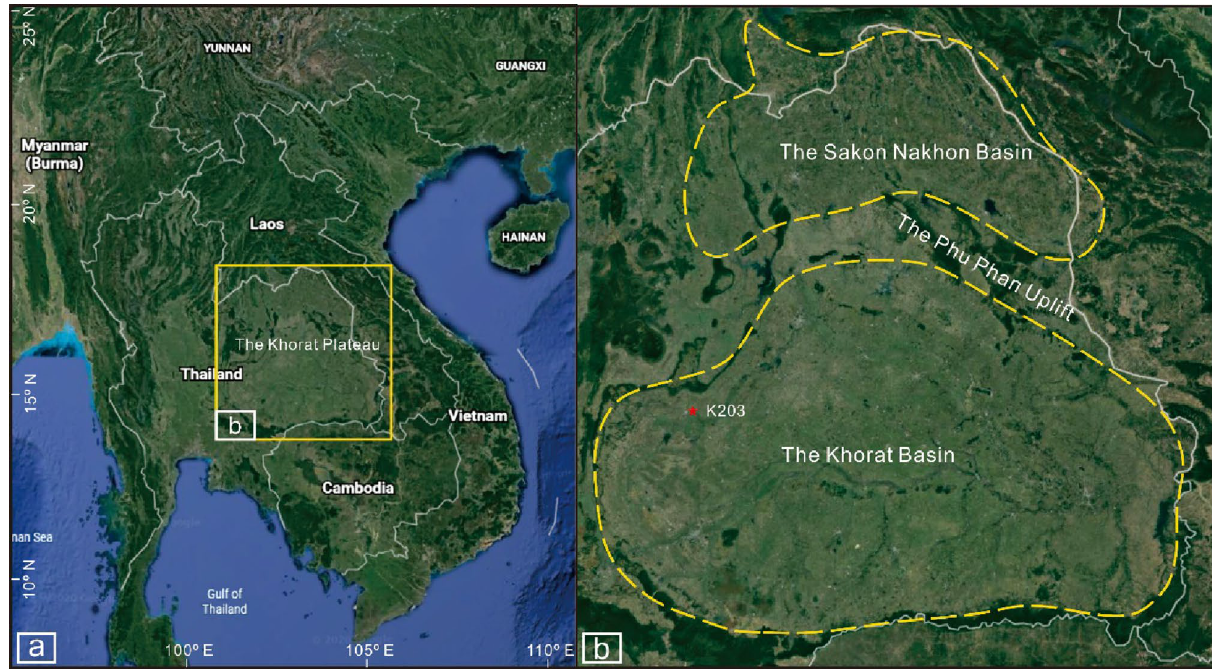
Figure 1. The distribution of the Khorat Basin and Sakon Nakhon Basin on the Khorat Plateau (modified from Google Earth). ( a ) The location of the Khorat Plateau; ( b ) the distribution of the Sakon Nakhon Basin and the Khorat Basin 7